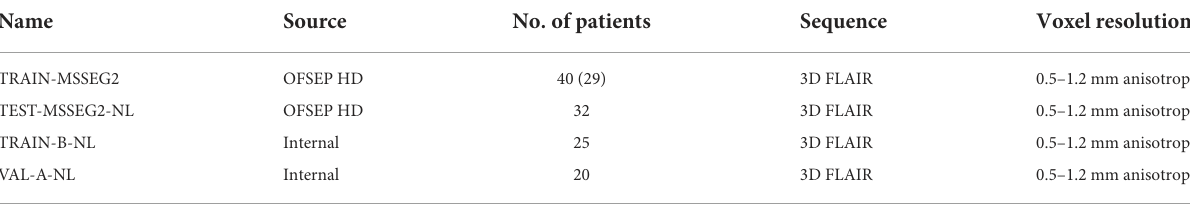
TABLE 1 Datasets used for training, validation, and testing, provided by the MSSEG-2 challenge organizers and internal